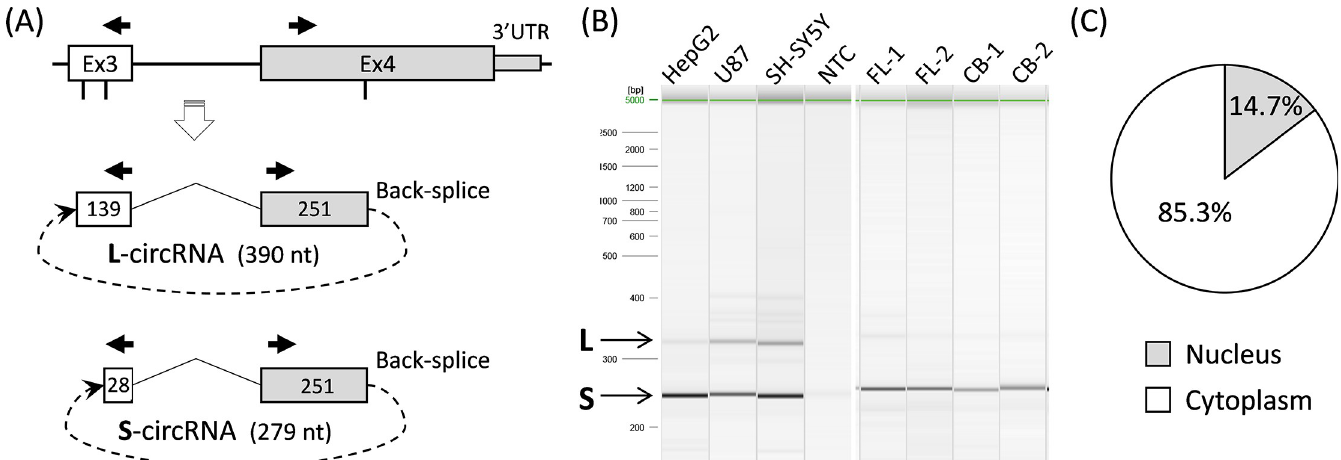
Fig 3. Map and features of APOE circRNA. (A) Diagram shows the origin of circRNA from Exs 3 and 4 of the APOE gene. Circular structure and size of both L- and S- circRNAs are shown. Vertical lines under exons indicate back-splice junction sites, and dotted lines indicate a back-splicing of Ex4 to Ex3. Solid arrows represent outward-facing primers used to amplify circRNAs. (B) Gel picture shows PCR products of L- and S-circRNAs from three cell lines (HepG2, U87, and SH-SY5Y) and PMB samples (FL-1, FL-2, CB-1, and CB-2]). (C) Pie chart shows that APOE circRNAs are present mainly in the cytoplasm ( > 85%) as determined by qRT-PCR on cellular fractions from HepG2 cultures. CB: cerebellum; circRNA: circular RNA; Ex: exon; FL: frontal lobe; L: large; NTC: no template control; PCR: polymerase chain reaction; PMB: postmortem brain; qRT: quantitative reverse transcriptase; S: small.